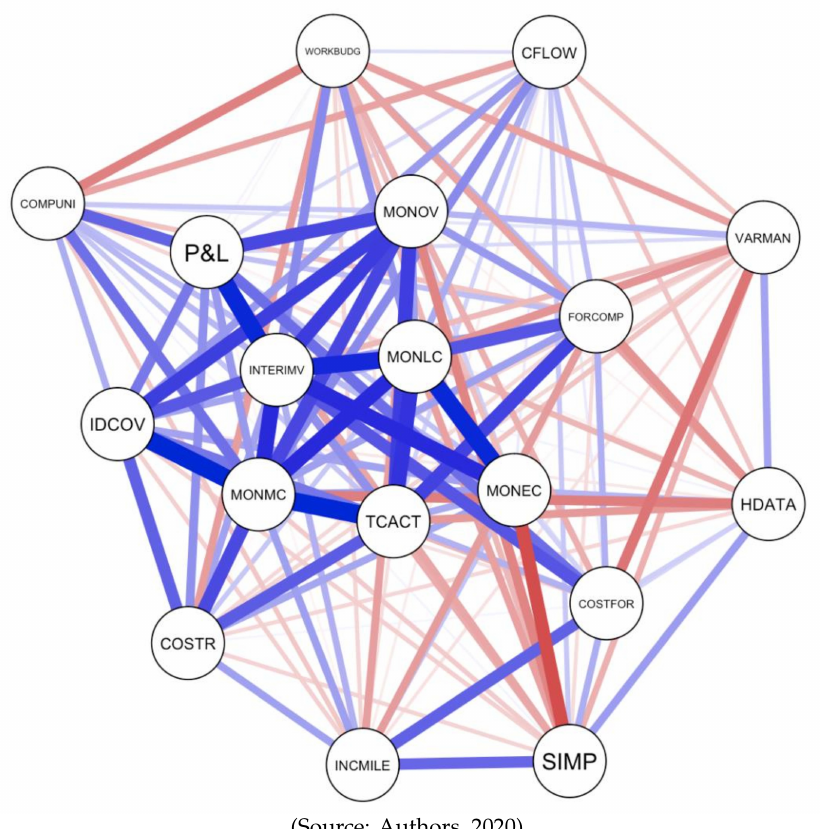
Figure 8. Network plot for